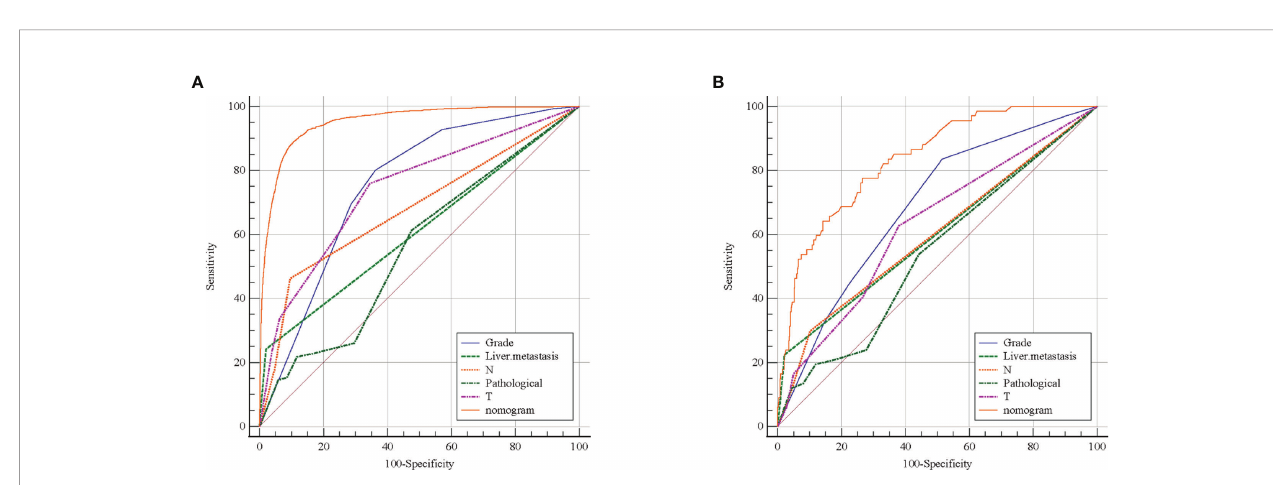
FIGURE 2 | Receiver operating characteristic (ROC) curve evaluated the performance of predictive model. The training group (A) and external validation group (B) showed the nomogram has better predictive performance than any single